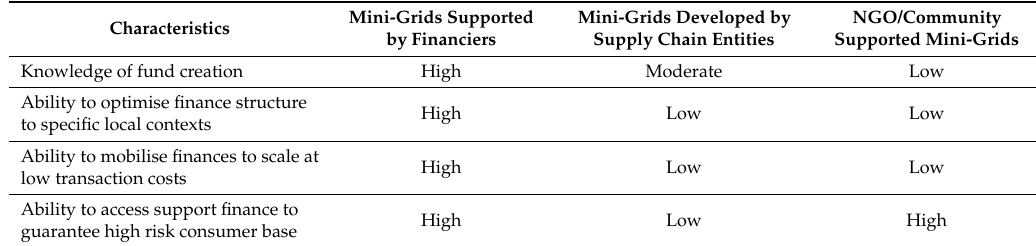
Table 5. Mapping of comparative finance-related strengths and weaknesses of mini-grid types. Source: [70].